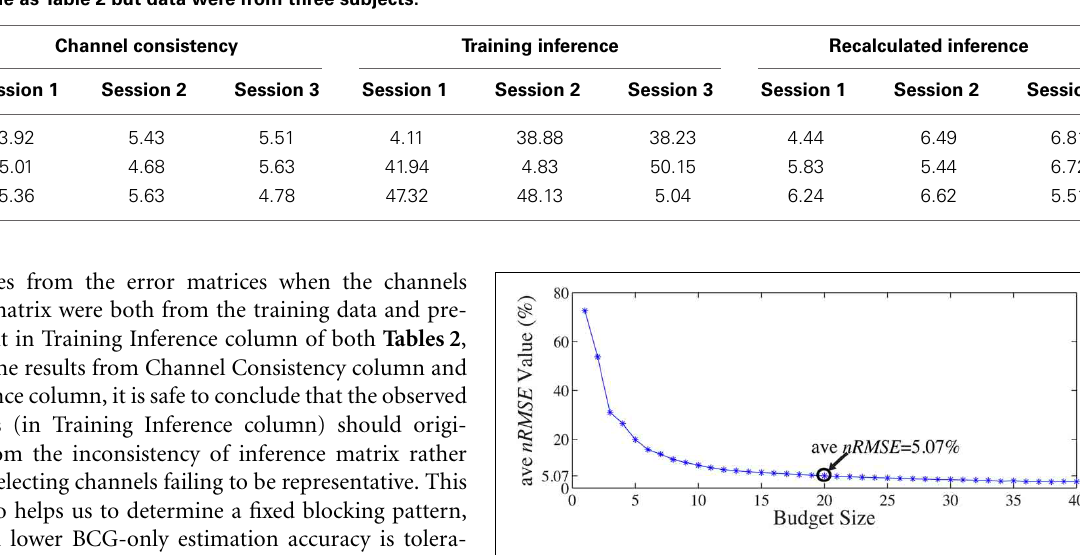
FIGURE 9 | Mean ave nRMSE (%) of 12 validation sets as a function of “budget” size.